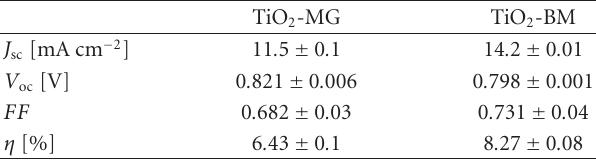
Table 1: Photoelectric characteristics of DSCs fabricated using TiO 2 -MG paste and TiO 2 -BM paste. Each data was the average of three